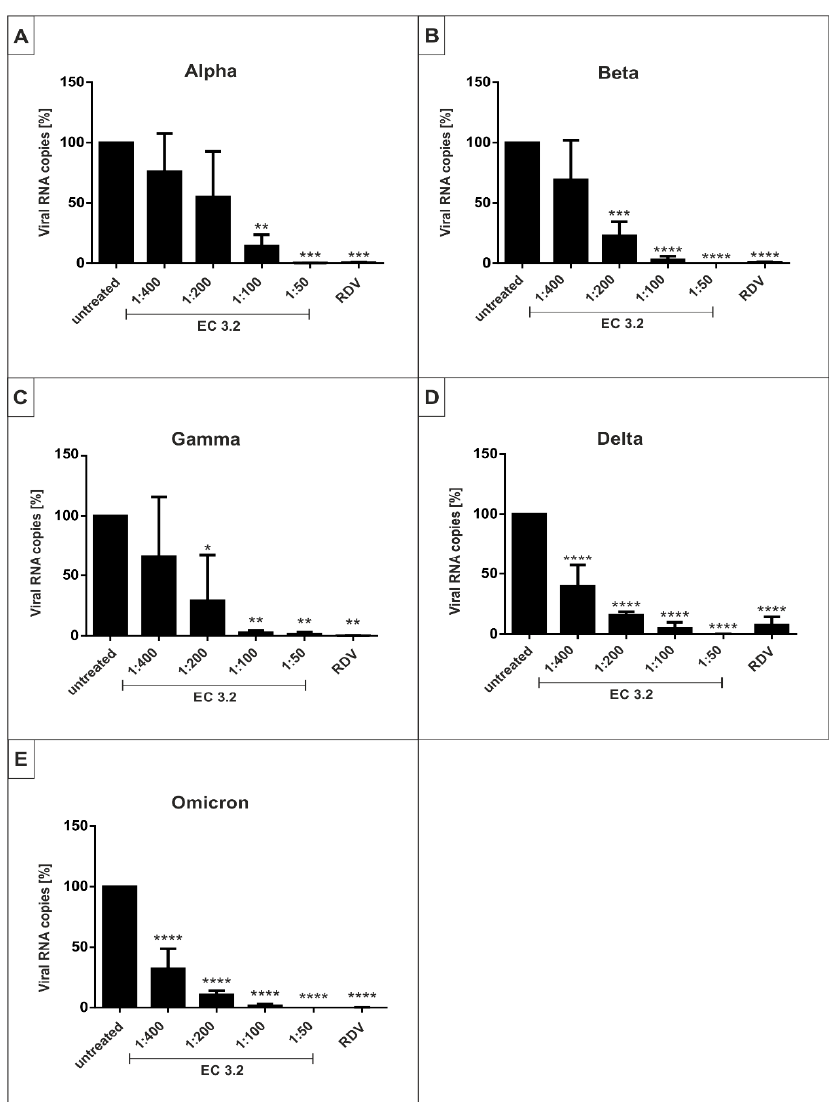
Figure 6. EC 3.2 inhibits replication of the SARS-CoV-2 Variants of Concern (VoCs) Alpha, Beta, Gamma, Delta and Omicron with comparable antiviral efficacy. Calu-3 cells were infected with clinical isolates of the SARS-CoV-2 VoCs Alpha ( A ), Beta ( B ), Gamma ( C ), Delta ( D ) or Omicron ( E ) at a MOI of 2 × 10 − 2 . One hour after infection and removal of input virus, cells were treated with the indicated dilutions of EC 3.2. A total of 1 μ M RDV was included as a positive control. Cell culture supernatants were harvested at 3 dpi. The virions were purified and analyzed by qRT-PCR. Bars show mean values of three independent experiments ± standard deviation. Statistical analysis was performed using a multiple comparison Kruskal–Wallis test (Anova) followed by Dunn’s post hoc test (* p < 0.05; ** p < 0.01; *** p < 0.001; **** p < 0.0001 versus the untreated control). Treatment with EC 3.2 led to a dose-dependent reduction of virus replication that occurred with comparable efficacy for all VoCs (Figure 6). The IC 50 values varied between ~ 1:800 for the Wuhan type (Figure 3) and ~1:200 for Alpha (Figure 6). However, the IC 90 was ~ 1:100 for all VoCs and thus in a similar range (Figure 6).